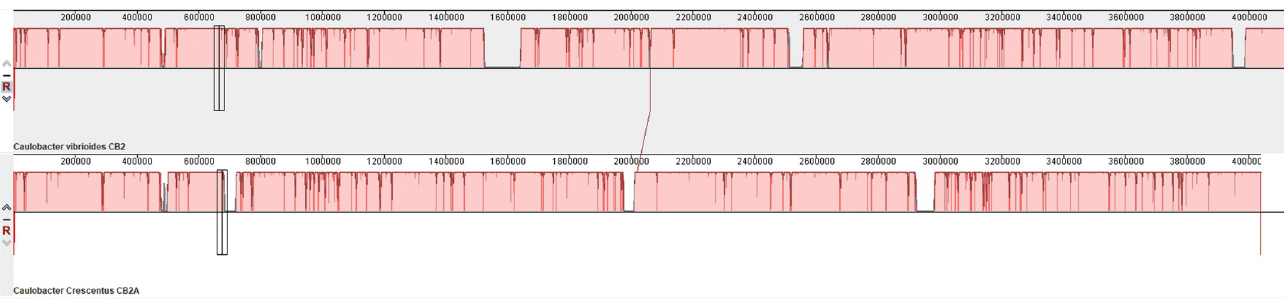
Fig 1. A comparison of the entire CB2 (top) and CB2A (bottom) genomes showing that small segments of the NA1000 genome are present throughout the entire CB2A genome. The horizontal red bars show that most of the CB2A genome is identical to the CB2 genome. The exceptions are the narrow regions darker red vertical lines where the CB2A genome nucleotide sequence is identical to that of the NA1000 genome. The white spaces within the lower red band that represents the CB2A genome indicate areas where the CB2A genome contains NA1000 sequences that have no corresponding region in the CB2 genome. Similarly, the gray spaces within the top red band that represents the CB2 genome correspond to regions of the CB2 genome that have been deleted from the CB2A genome.